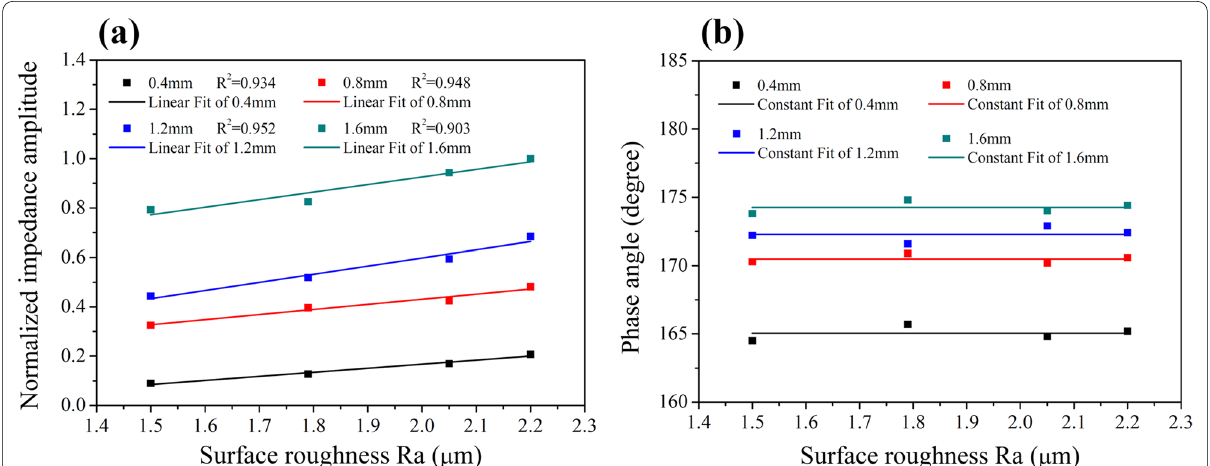
Figure 14 Relationship between surface roughness Ra and ( a ) the normalized impedance amplitude and ( b ) the impedance phase angle of the captured defect EC